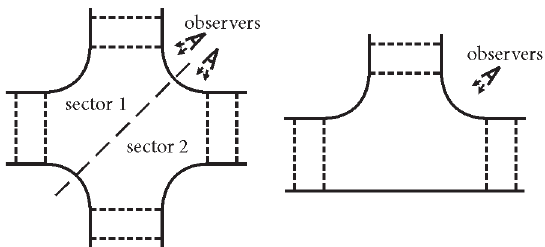
Fig. 5. The scheme of disposition of observers while monitoring conflict